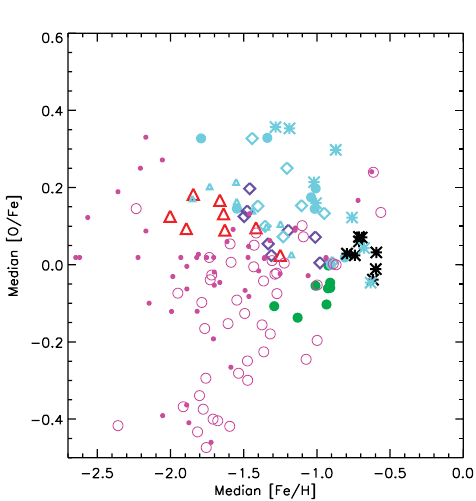
Figure 3. [O/Fe] medians versus [Fe/H] medians for stars in the four stellar components: central spheroids (black), disc (green), inner halo (violet) and outer halo (red), for stars acquired from infalling satellites (cyan) and for stars in surviving satellites (magenta) within the virial